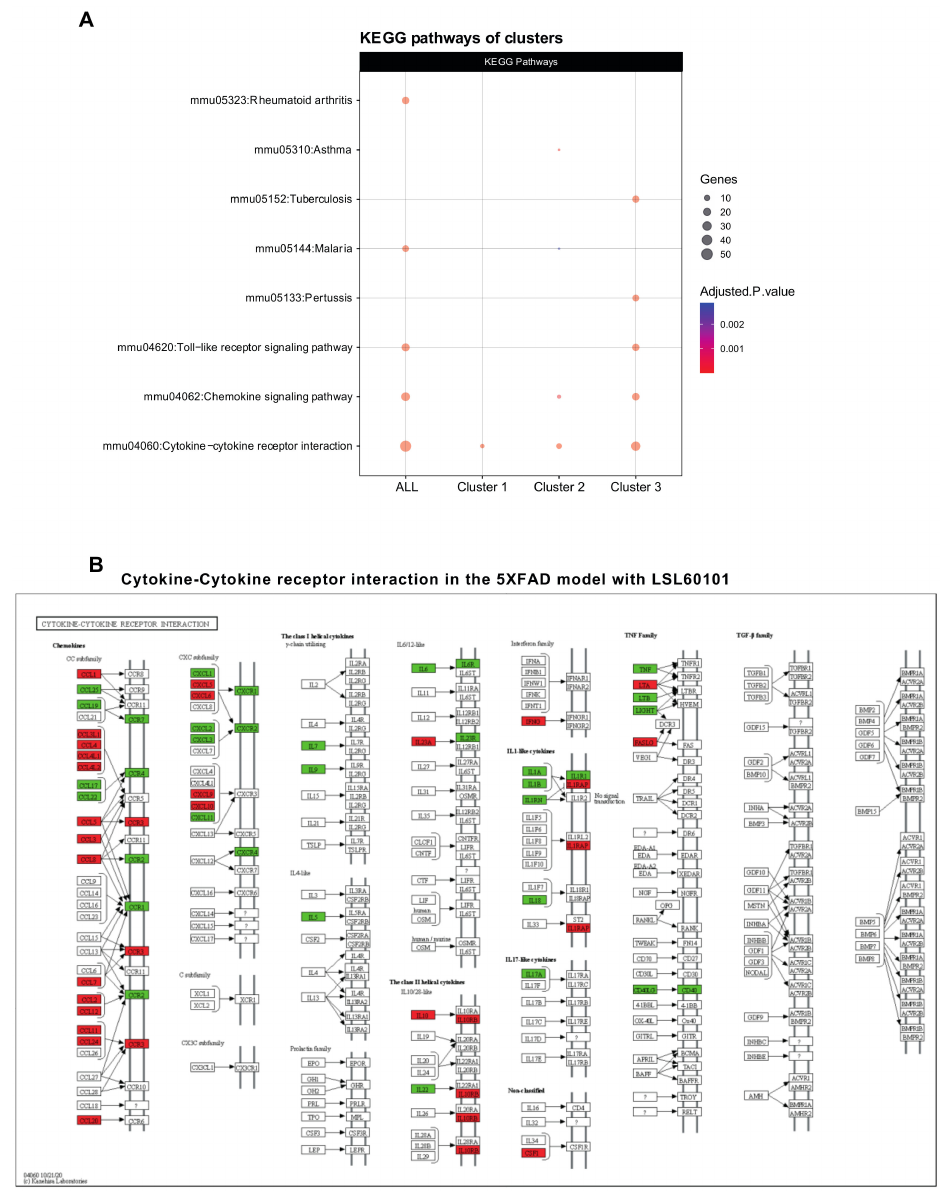
Figure 3. KEGG pathway analysis and cytokine–cytokine receptor interaction pathway. ( A ) The dotplot shows the top KEGG pathways of the clusters. The cytokine–cytokine receptor interaction is representative of the three clusters. An adjusted p -value < 0.05 was considered statistically significant. ( B ) The KEGG pathway map cytokine–cytokine receptor interaction (mmu04060) is shown. The downregulated (green) and upregulated genes (red) in the 5XFAD control condition versus the 5XFAD LSL60101 condition are